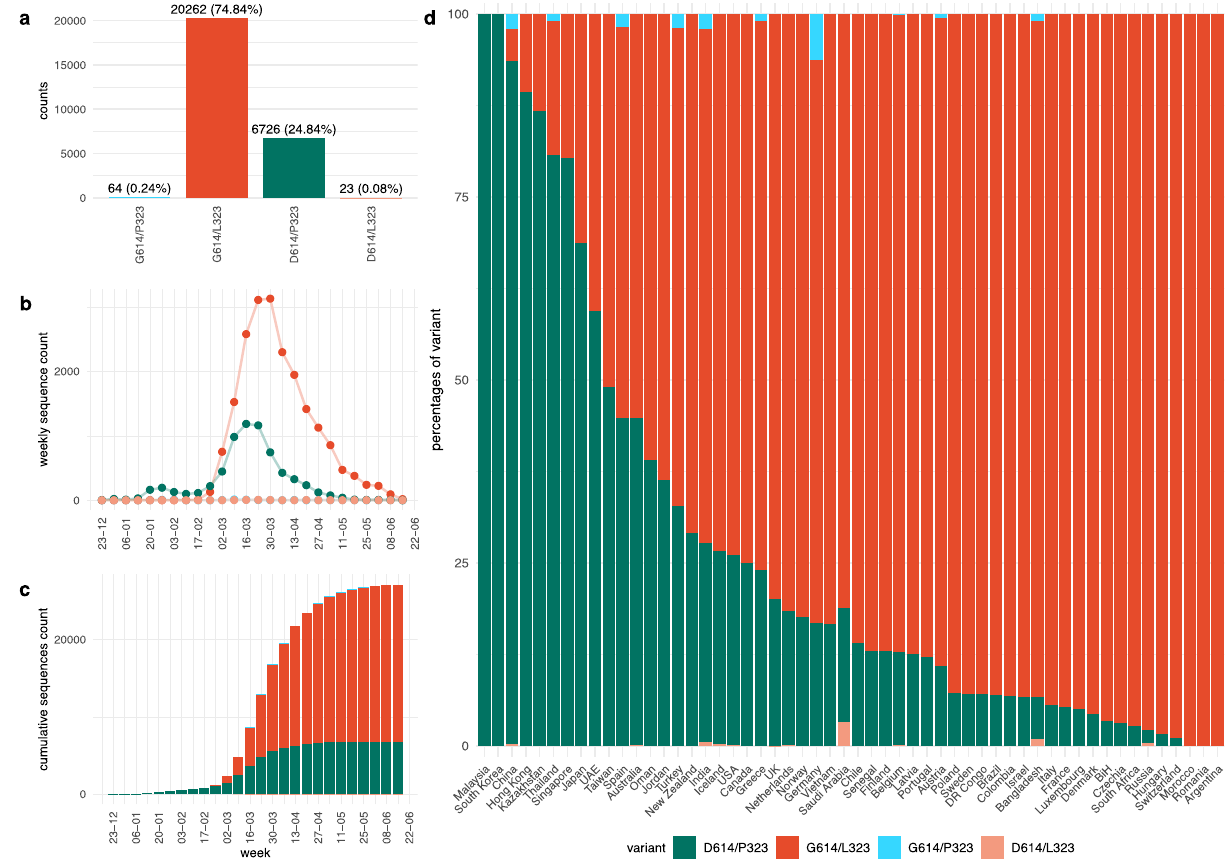
Figure 4. Temporal and spatial distribution of the four possible D614G and P323L combinations. Available high-quality sequences of SARS-CoV-2 (27,075) were analysed. ( a ) G614/L323 (double mutant) represented more than two-thirds, and D614/P323 (the original Wuhan sequence) about one-third of sequences; the single mutant variants G614/P323 and D614/L323 were very rare, ( b ) weekly number of variants over time; ( c ) cumulative number of variants over time. ( d ) Percentage of variants in different countries; only countries with at least 20 sequences are